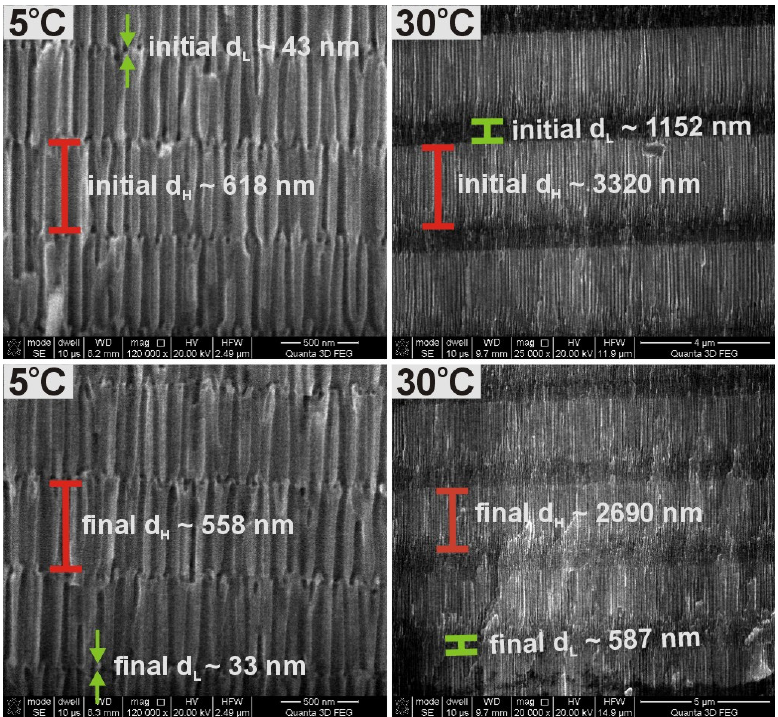
Figure 2. SEM images of a cross sectional view of the initial and final PAA segments obtained during the pulse anodization at 5 °C (the sample PAA—5 °C) and 30 °C (the sample PAA—30 °C).